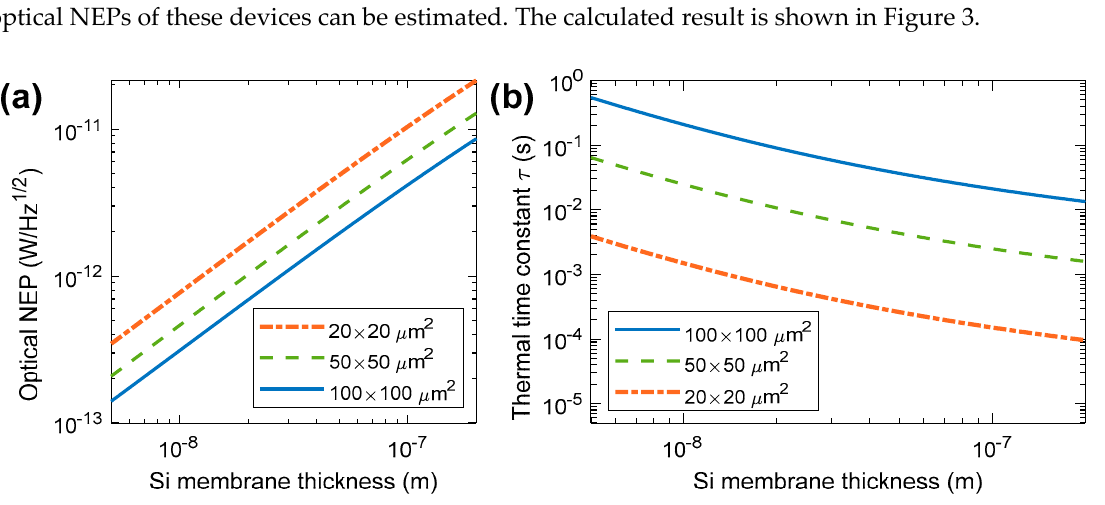
Figure 3. Calculated ( a ) optical NEP and ( b ) thermal time constant of the thermoelectric bolometers with various sizes as functions of the silicon nanomembrane thickness